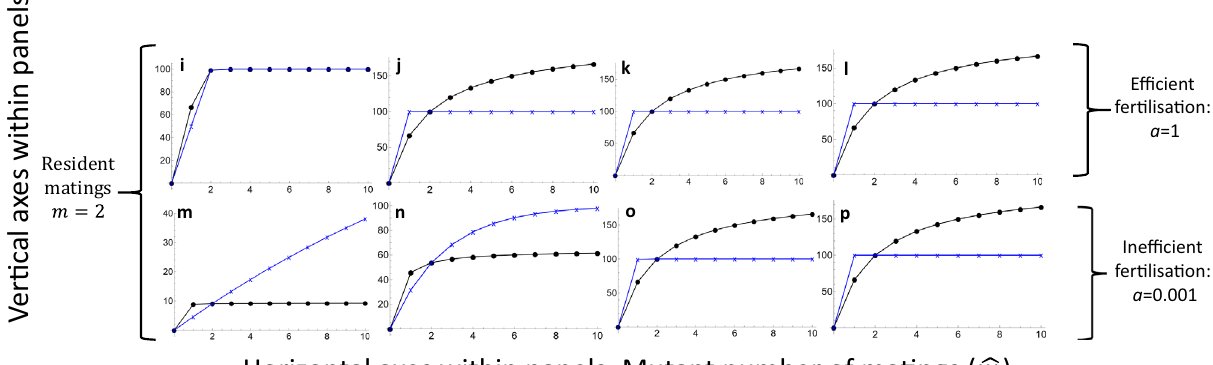
Horizontal axes within panels: Mutant number of ma(cid:2)ngs ( Fig. 3 The Bateman functions of Eqs. (3) and (4) for internal fertilisation. Where Figs. 1 and 2 show that the sex-speci fi c shapes of Bateman functions are ultimately caused by differences in gamete number, Fig. 3 shows that internal fertilisation does not invalidate this outcome when fertilisation is ef fi cient. As in Fig. 2, results are shown for two values of resident matings (1 and 2), and the value m = 2 is used because it is comparable to the mean number of matings in Bateman ’ s 1 work. a – h show the effect of variation in sex-speci fi c gamete numbers and in fertilisation ef fi ciency with m = 1, while i – p show the same with m = 2. Parameter values used are shown in the fi gure. Inef fi cient fertilisation combined with relatively low asymmetry in gamete numbers and the added asymmetry of internal fertilisation can in principle reverse the Bateman gradients (second and fourth row). Females (gamete number n x ) are indicated by blue crosses and connecting lines, while males (gamete number n y ) are indicated by black dots and connecting